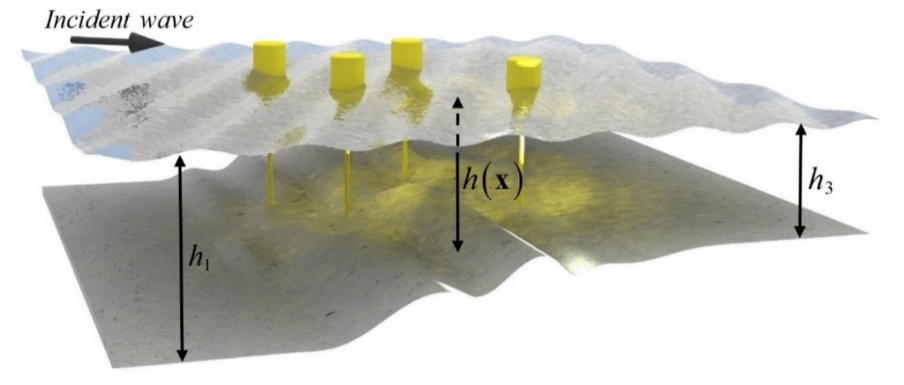
Figure 1. Array of WECs in variable bathymetry